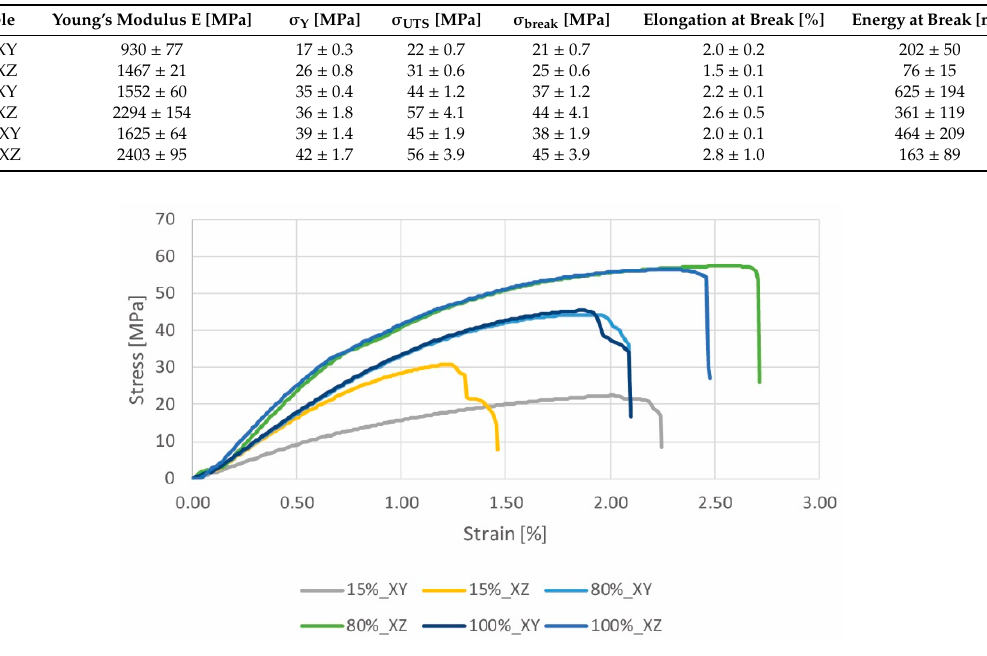
Figure 4. Stress-strain curves.